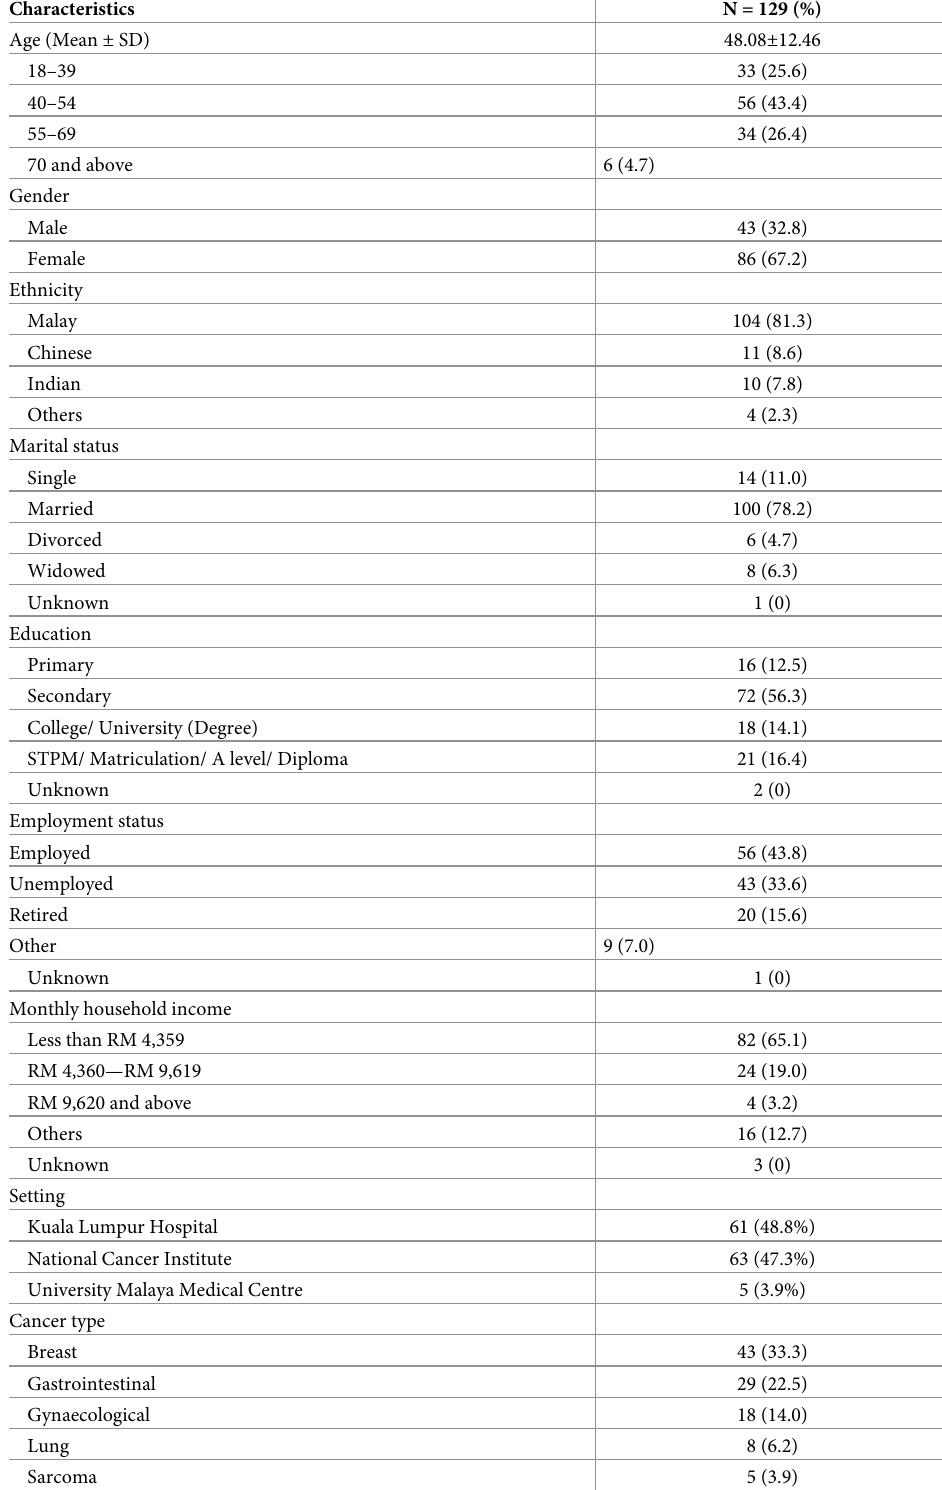
Table 1. Patient socio-demographic characteristics (n =